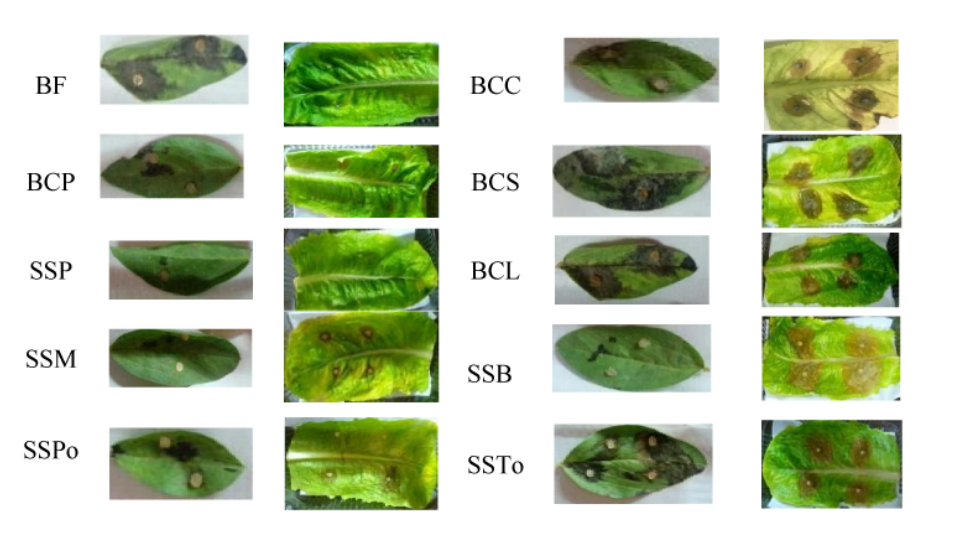
Figure 1 Pathogenicity test of different isolates of Botrytis spp. and Sclerotinia sclerotiorum on detached leaves of broad beans (left) and lettuce